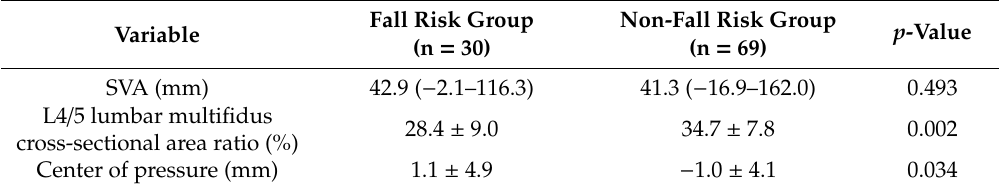
Table 2. Demographic characteristics associated with the functional and morphometric